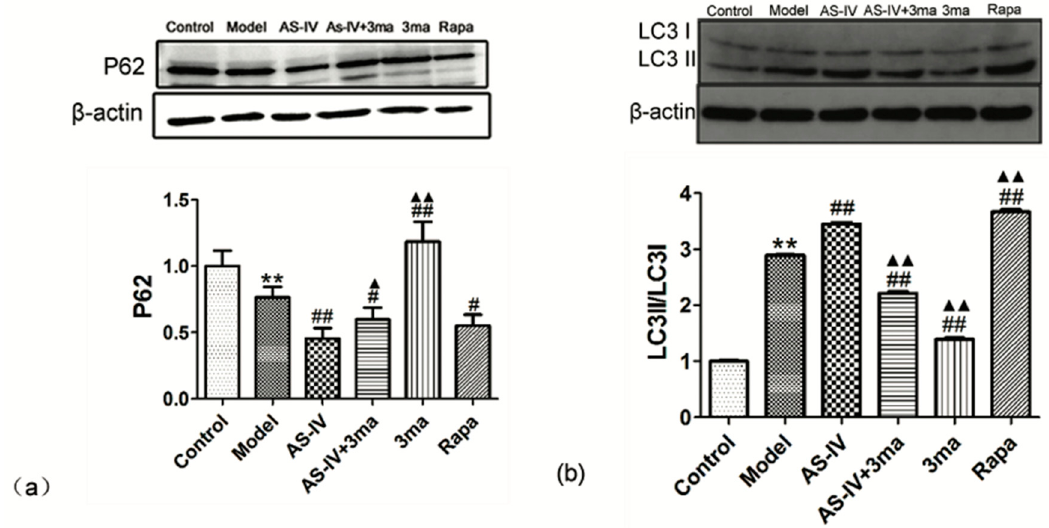
Figure 7. Enhancement of autophagy by Astragaloside IV after OGD/R. ( a ) The expression of P62 in HT22 cells after OGD/R with different treatments ( ** p < 0.01 vs. control, # p < 0.05, ## p < 0.01 vs. model and ▲ p < 0.05, ▲▲ p < 0.01 vs. AS-IV); ( b ) LC3II/LC3I in HT22 cells after OGD/R with different treatments ( ** p < 0.01 vs. control, ## p < 0.01 vs. model and ▲▲ p < 0.01 vs. AS-IV). Representative photographs obtained from each group (above) and statistical analysis from all cells in each group (below).